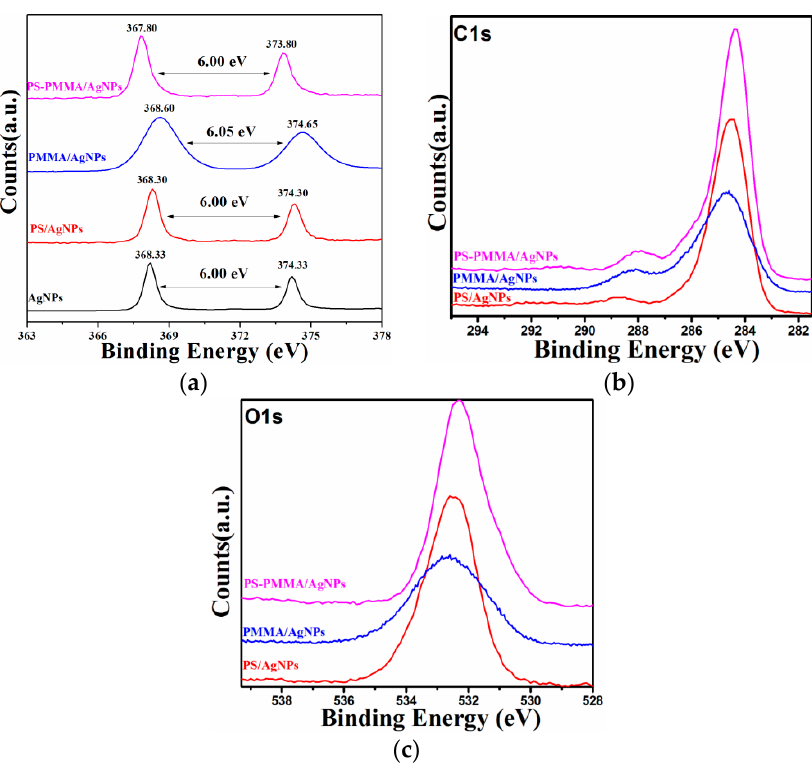
Figure 3. ( a ) Ag 3d XPS spectra of AgNPs; ( b ) C 1s XPS; and ( c ) O 1s spectra of polymer/AgNPs